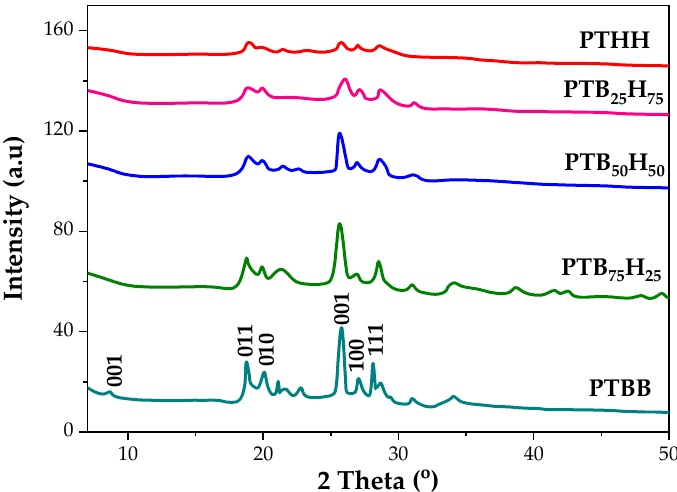
Figure 3. X-ray diffractogramms of poly(1,4-bis(2-hydroxyethyl)benzene thiophenedicarboxylate) (PTBB), poly(hexylene thiophenedicarboxylate) (PTHH), and poly(hexylene 2,5- thiophenedicarboxylate-co-bis(2-hydroxyethoxybenzene) (PTB x H y ) copolyesters.